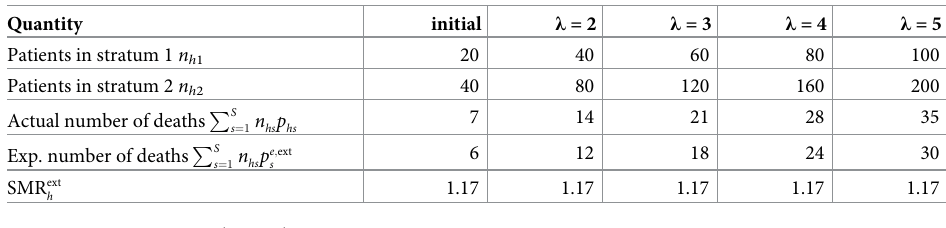
Table 2. Example of variations in hospital size under external standardization.